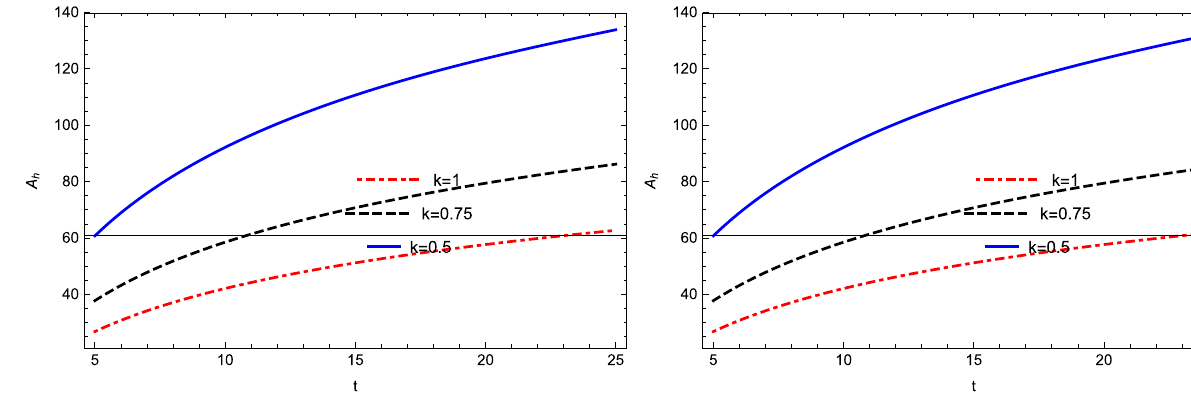
Fig. 4 Plot of A h verses t for n = − 2 . 8 and n = − 3 . 8 for Bianchi type-III model